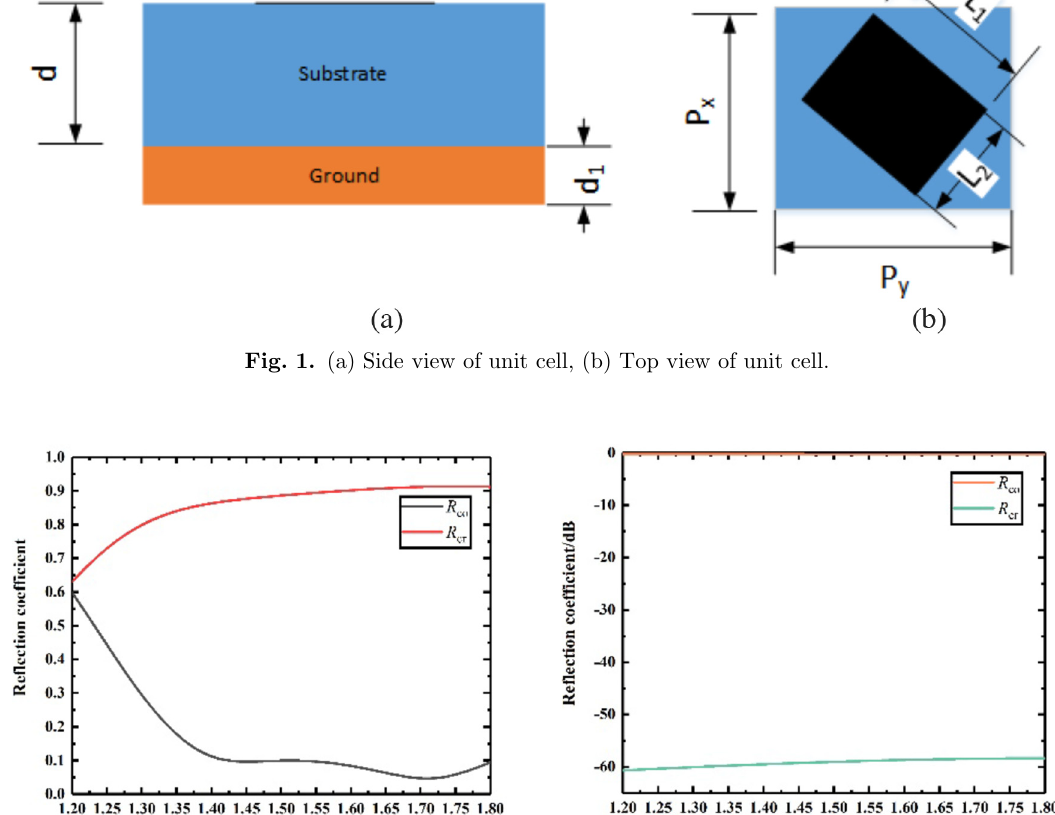
thickness is 13 m m, Silicon is chosen as dielectric substrate and relative dielectric constants e r = 3.84. The thickness of metal layer is 2 um, the period of unit cell is Px * Py , Px = Py = 40 m m.